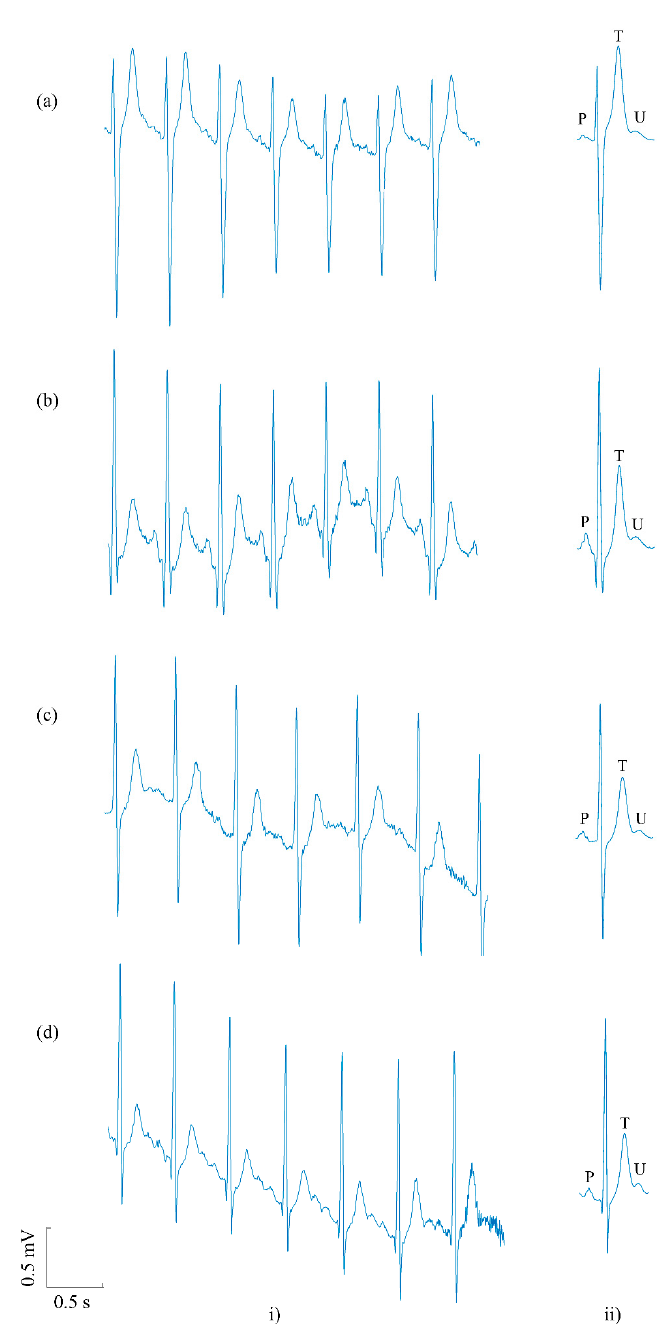
Figure 3. Examples illustrating the recovery of U waves in four subjects ( a – d ) from post-exercise recordings using the beat averaging algorithm. ( i ) A 4 s strip of post-exercise ECG in which it is di ffi cult to recognise U waves in the four subjects. ( ii ) The corresponding averaged beat in post-exercise with a clear U wave following the T wave.